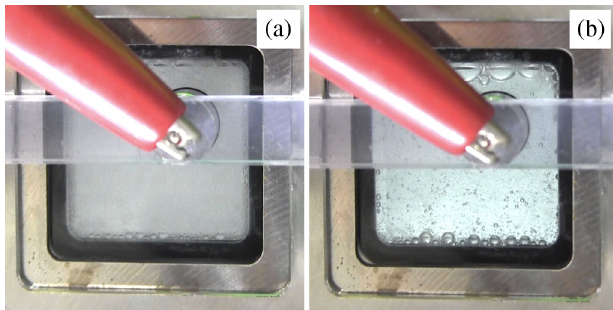
FIG. 15. Two pictures of the viewport near the top iris in the top cell during VEP performed with (a) single flow at 5 L = min and (b) dual flow at 5 L = min in the cavity and 10 L = min in the cathode housing. The cathode rotation was set at 20 rpm. The lower brightness of backlight in (a) is caused by the excep- tionally large quantity of bubbles in the cell. The size of the viewport is 25 × 25